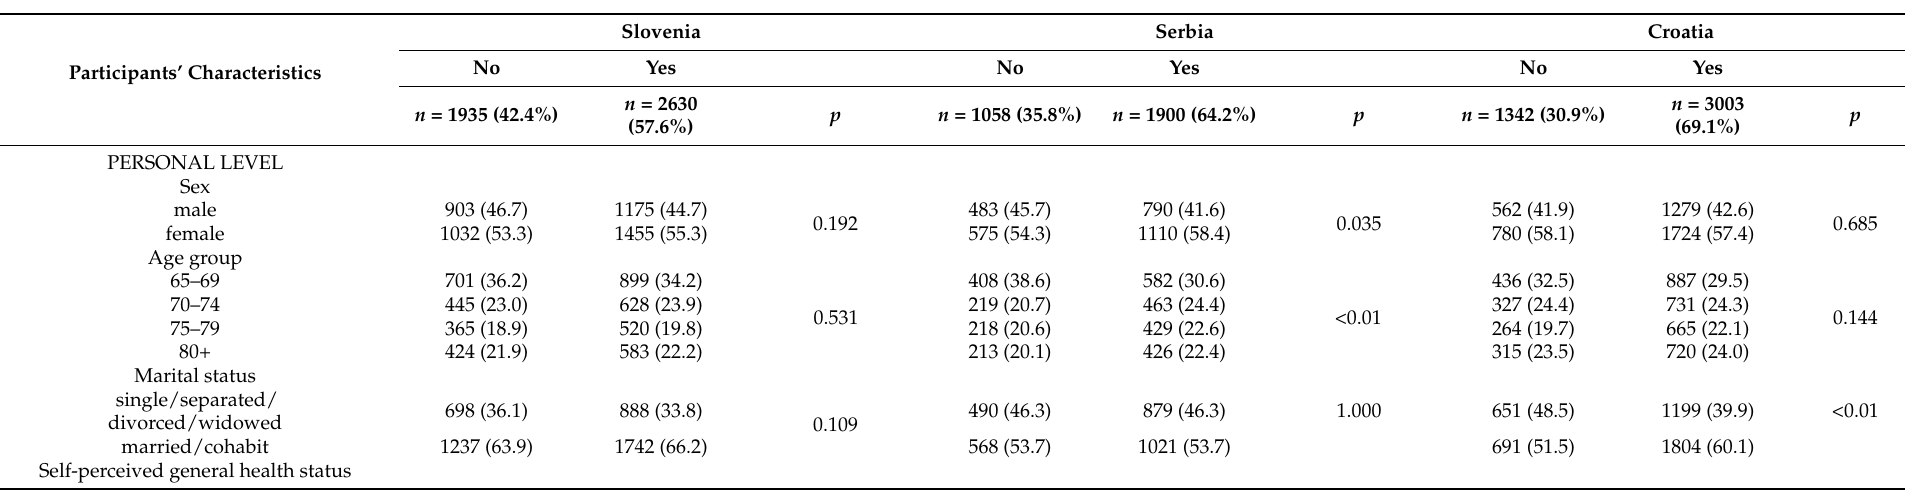
Table 5. Distribution of participants with and without the financial burden of medicines in Slovenia, Serbia, and